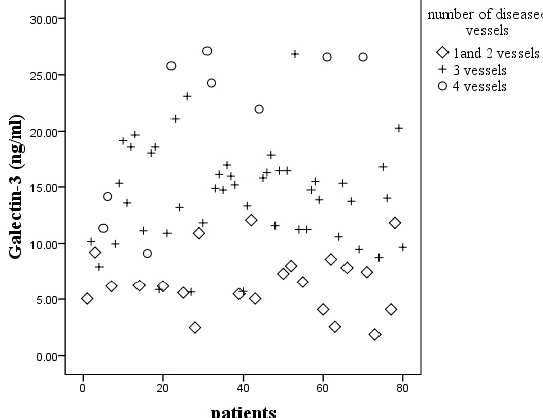
Figure 1. Levels of galectin-3 in the patients’ sera (The values are mean (95% CI) Table 2. Linear regression analyze for predictive effect of CAD severity on galectin-3 regarding confounding factors